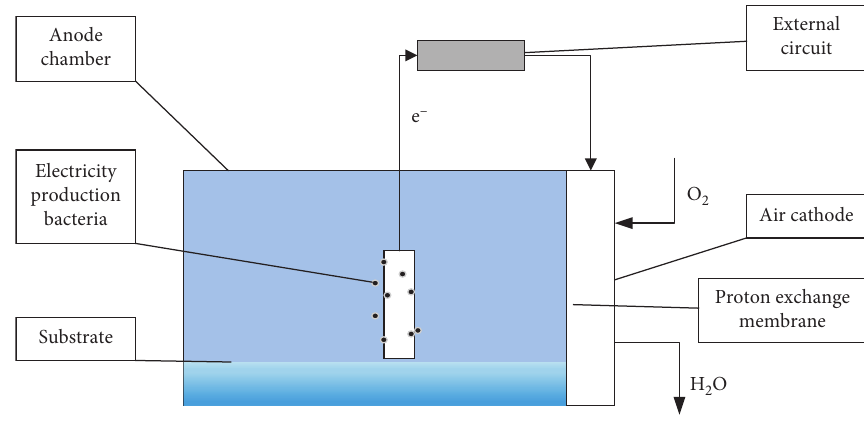
Figure 1: Single-chamber MFC